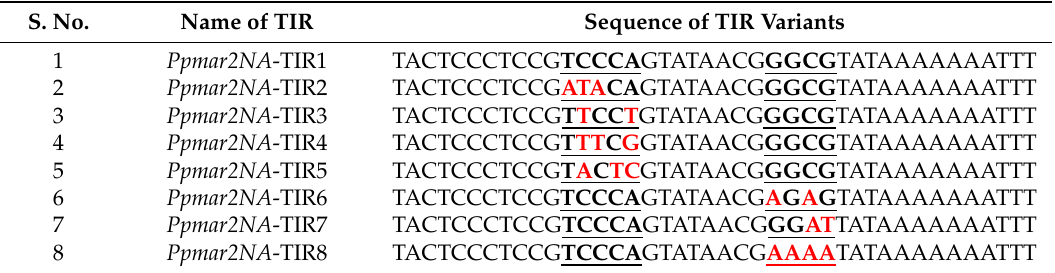
Ppmar2NA -TIR7 TACTCCCTCCG TCCCA GTATAACG GGAT TATAAAAAAATTT TACTCCCTCCG TCCCA GTATAACG AAAA